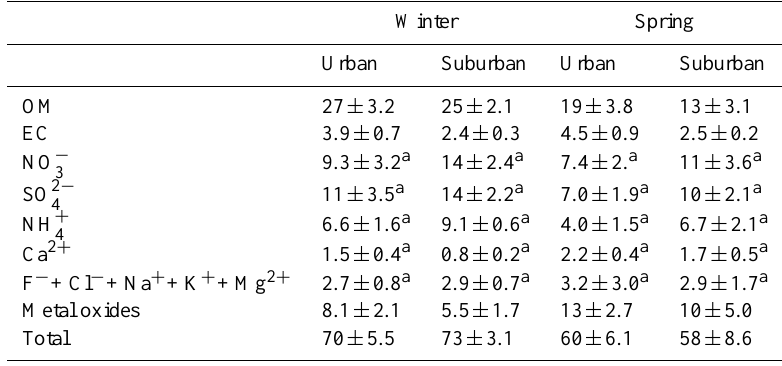
Fig. 5 Concentrations of major components determined in the PM 10 of Baoji City